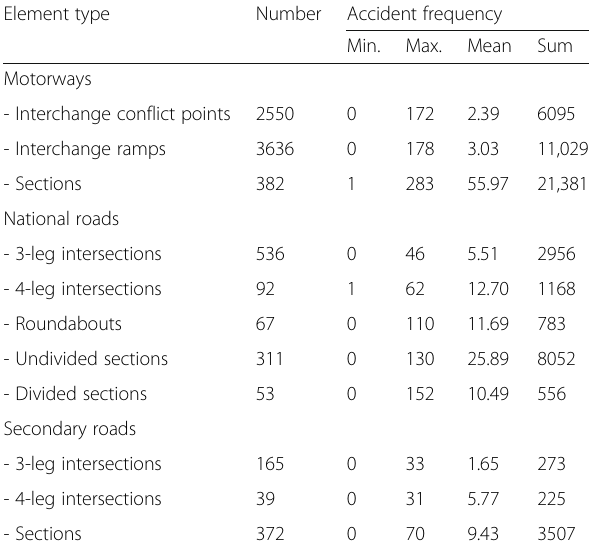
Table 3 Numbers of elements and descriptive characteristics of their accident data Element